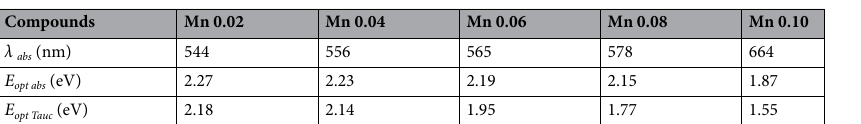
Table 3. Absorbed wavelength from Kubelka–Munk plot, E opt from Kubelka–Munk plot, and E opt from Tauc plot in SrLaLiTe 1− x Mn x O 6